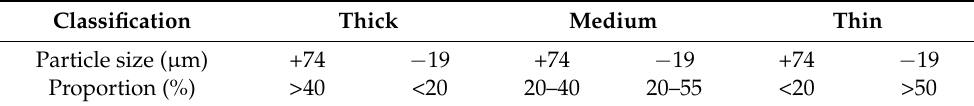
Table 5. Common classification standards of tailings in domestic mines.